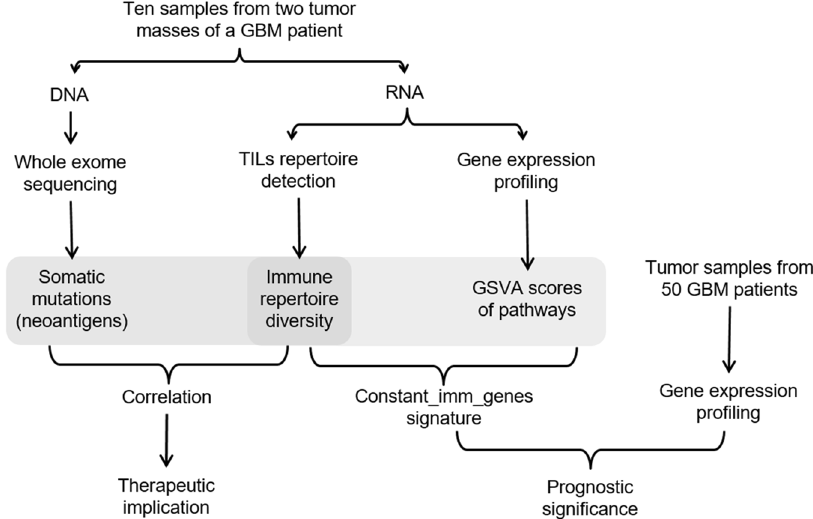
Figure 1. Schematic diagram of the study